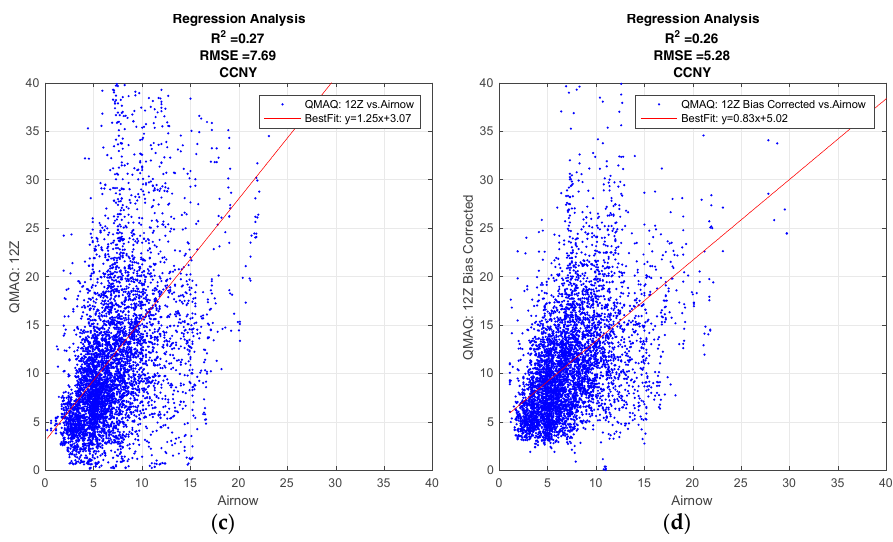
Figure 1. Community Multi-Scale Air Quality (CMAQ) regression analysis. ( a ) Standard, 06Z release time; ( b ) Bias Corrected, 06Z release time; ( c ) Standard, 12Z release time; ( d ) Bias Corrected, 12Z release time.